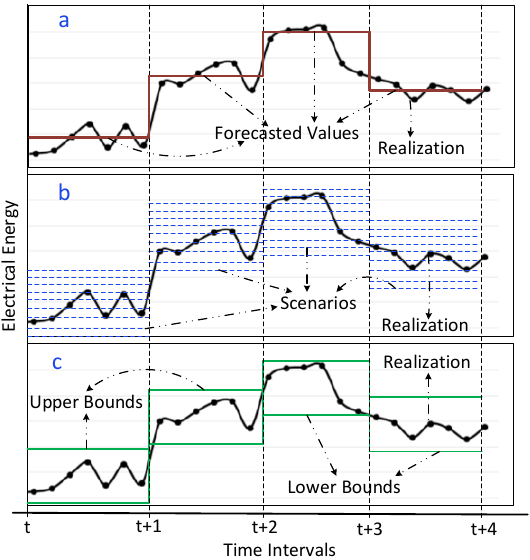
Figure 1. Uncertainty representation: ( a ) Deterministic optimization; ( b ) Stochastic optimization; and ( c ) Robust optimization.